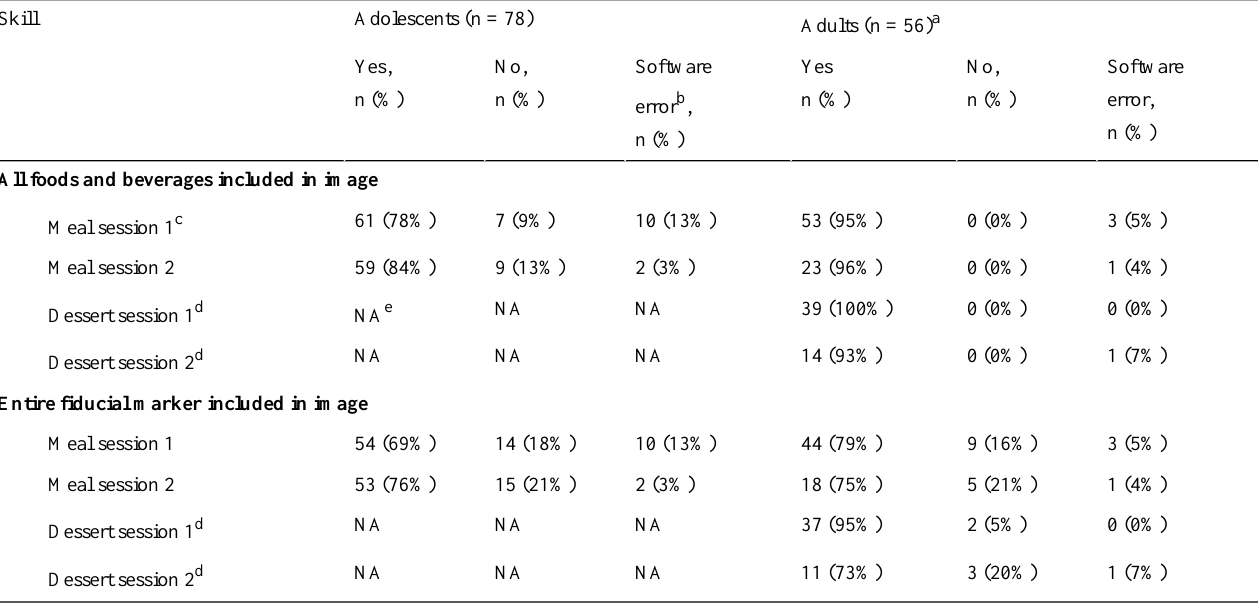
Table 2. Evaluation of participants’set of skills when capturing images with the mobile telephone food